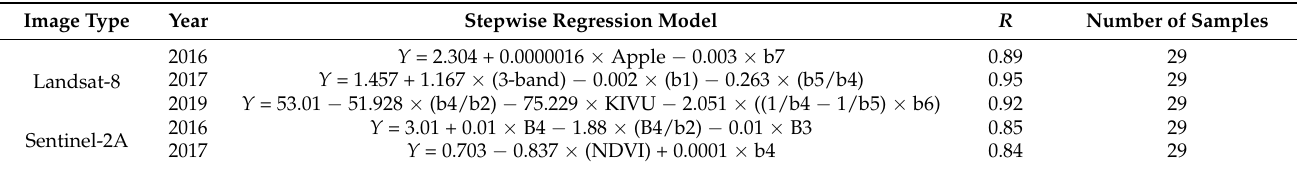
Table 6. The stepwise regression model with the highest correlation between simulated values and measured values based on Landsat-8 in 2016 and 2017, and Sentinel-2A in 2016, 2017, and 2019 in the Guanting Reservoir. Image